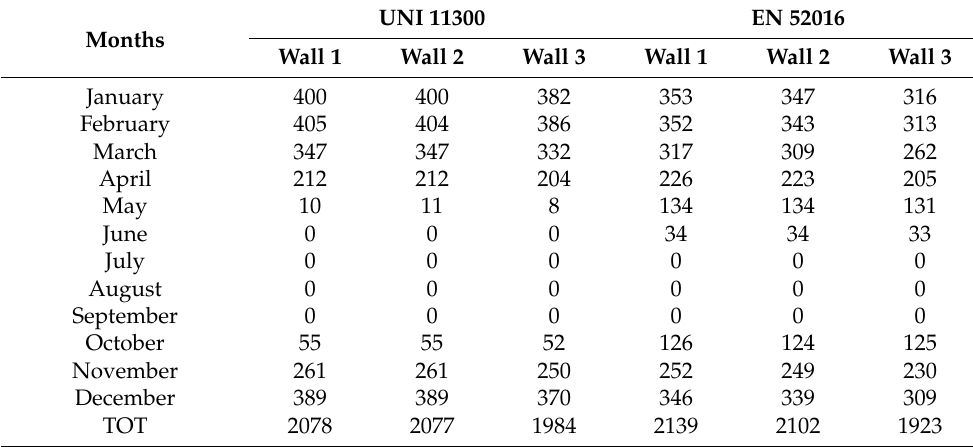
Table 8. Heat losses (kWh) during the winter period through the walls of a case study (detached house): comparison between UNI 11300 and EN